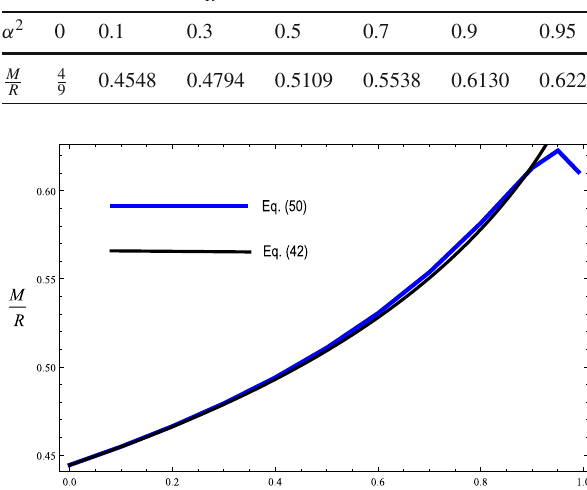
plotted against α 2 for Eqs. (42) and R